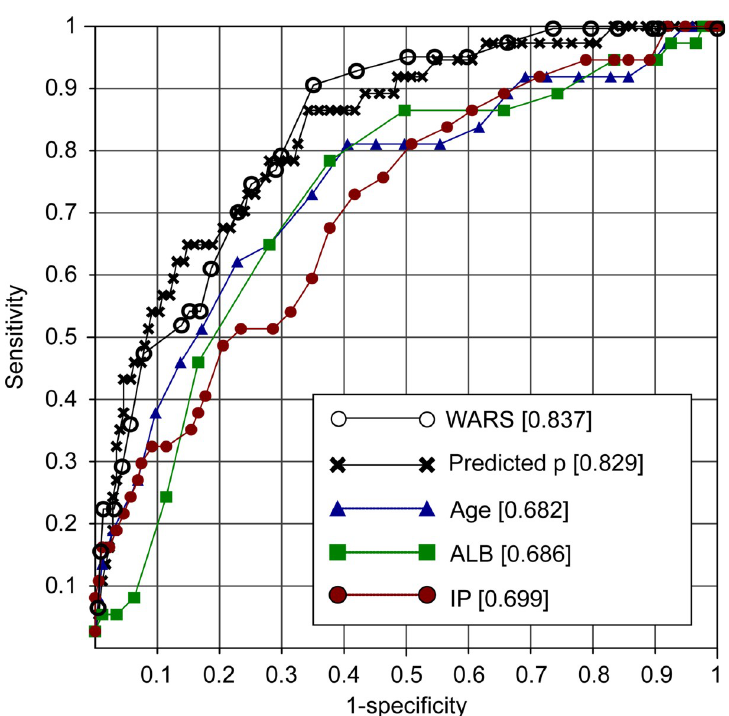
Fig 3. Comparison of the utility among mortality risk variables by ROC analysis. ROC analysis was performed using S1 Dataset to compare the utility of the following mortality risk variables: predicted probability (p) derived by MLRA, WARS, serum albumin, and serum IP. The C-statistics calculated for each variable is shown attached to its name.